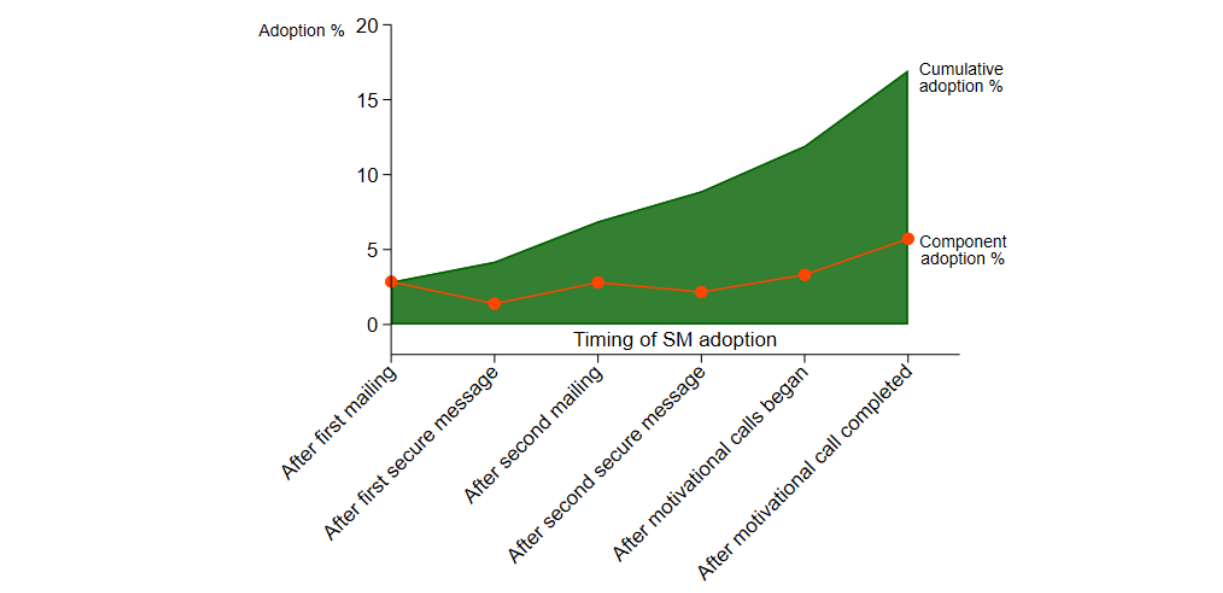
Figure 3. Adoption after each component and cumulative adoption over 9 months of active intervention among patients randomized to the Supported Adoption Program. SM: secure